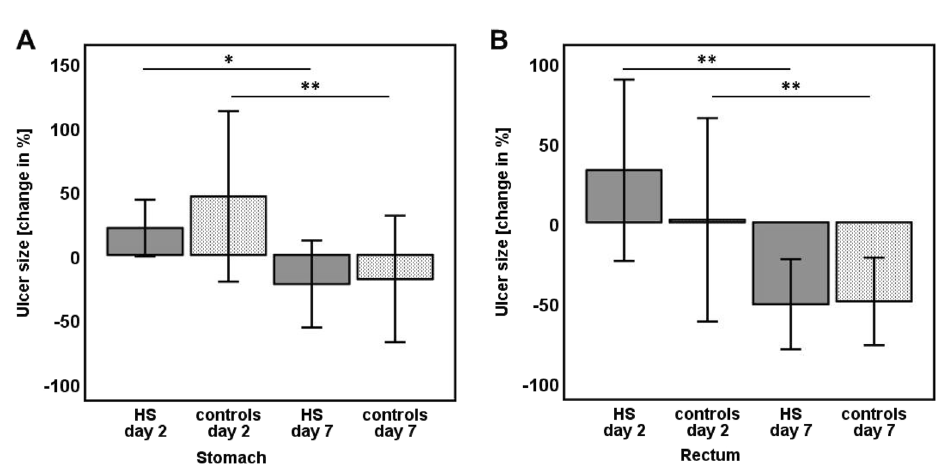
Figure 2. Changes in gastric and rectal ulcer size. Change in % relating to baseline, means and SD are shown. * p < 0.05, ** p < 0.03, Wilcoxon’s test. Changes in % in ulcer size between the HS-treated and the non-treated group of pigs were not significant on day 2, and 7 neither in the stomach nor in the rectum. HS